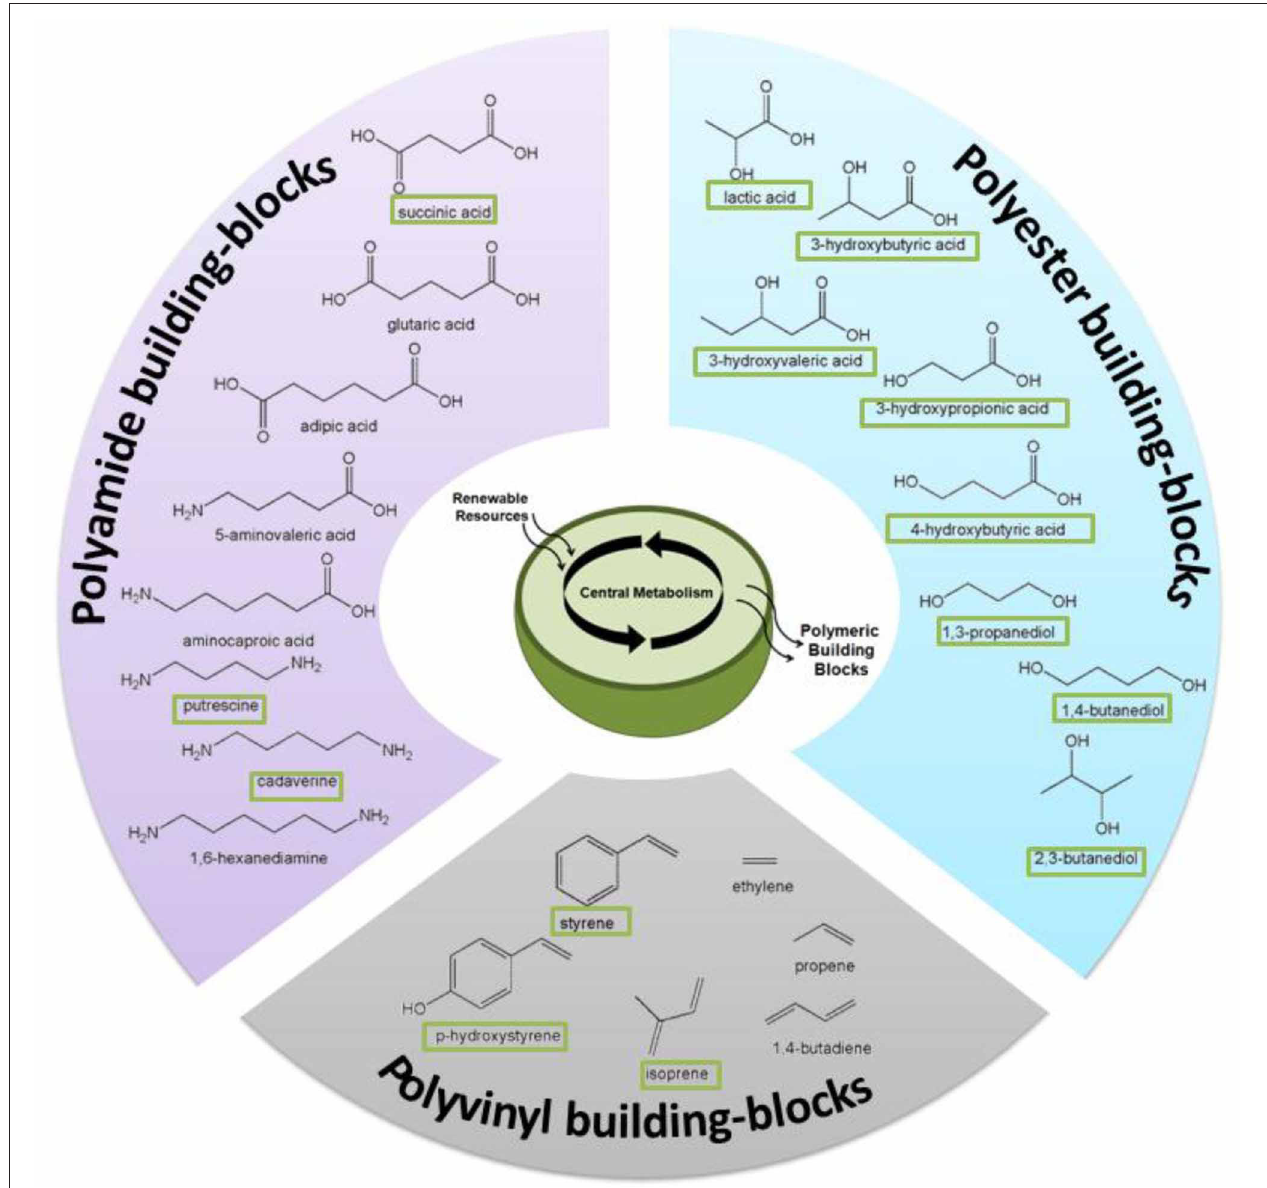
that have been produced directly from renewable resources, whereas others have been produced via a hybrid, biocatalytic-chemocatalytic